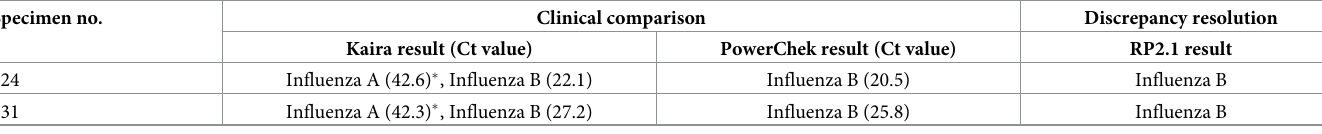
Table 4. Details of two specimens showing discordant results between the Kaira and PowerChek assays. Specimen no.